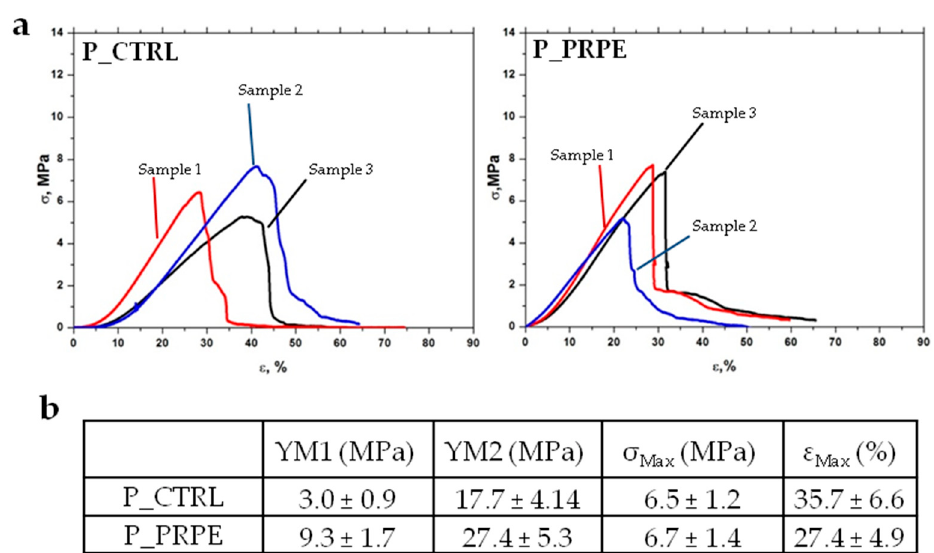
Figure 10. Tensile test in hydrate conditions for P_CTRL and P_PRPE membranes. ( a ) Stress–strain curves for P_CTRL and P_PRPE membranes; three replicates for each sample. ( b ) Mechanical parameters calculated from the stress–strain curves for both membranes.